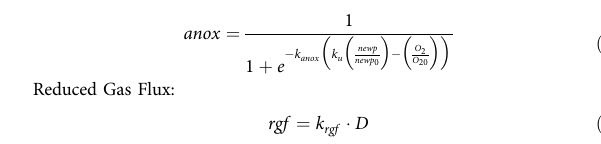
A fl ux of reduced gas, modelled as H 2 , is added to the model to explore the possibility that increased subduction and degassing rates may act to lower O 2 levels by delivering more reductant from the mantle. The rate of input is de fi ned by an assumed present-day rate ( k rgf ) and scales with the relative degassing rate. To maintain balance of the oxygen cycle at present day, the present day oxidative weathering fl ux is reduced by k rgf . This modi fi cation, in turn, requires an additional source of carbon to the surface system to maintain balance, which is represented by mid-ocean ridge degassing of CO 2 with magnitude equal to k rgf . We also assume that the large sedimentary reservoirs in the model (C, G, PYR, GYP) do not change over time. This avoids further model extension to link these reservoirs to the mantle 71 and is justi fi ed because the changes in the relative sizes of these reservoirs over the timescales we wish to consider are negligible (an average of 2.5% change over 100 Myrs in the model of Hayes and Waldbauer 71 ). Strontium isotope system . This study follows Lenton et al. 43 whereby the strontium cycle and its isotopes are implemented following Francois and Walker 72 and Vollstaedt et al. 73 with some improvements to the formulation described in Mills et al. 74 . Strontium fl uxes Mantle Sr Input: